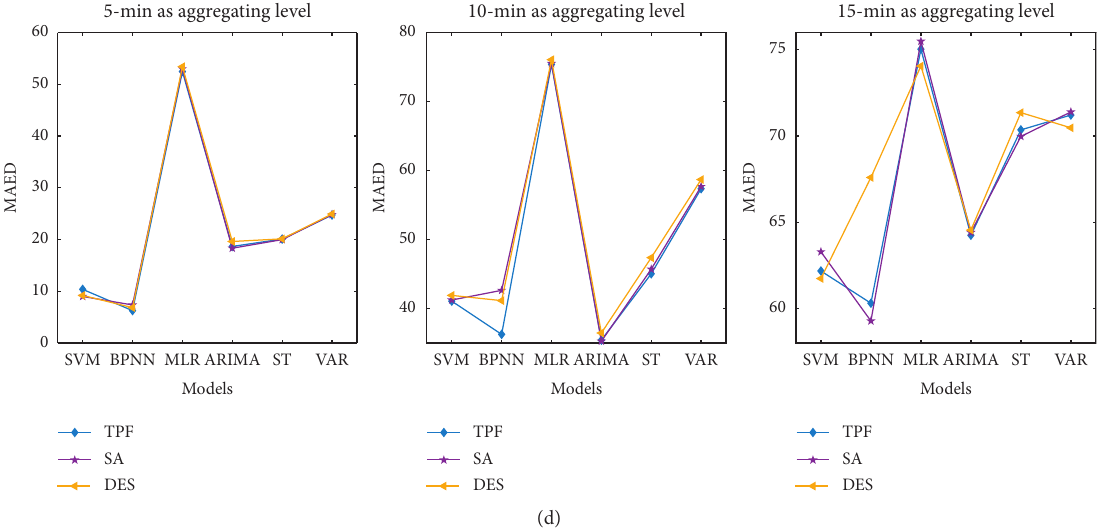
Figure 7: MAED for multistep ahead prediction with different aggregation levels (5-minute, 10-minute, and 15-minute). (a) MAED for 1- step ahead prediction. (b) MAED for 3-step ahead prediction. (c) MAED for 6-step ahead prediction. (d) MAED for 12-step ahead prediction. Table 4: Aggregation level suggestions and periodic function suggestions.